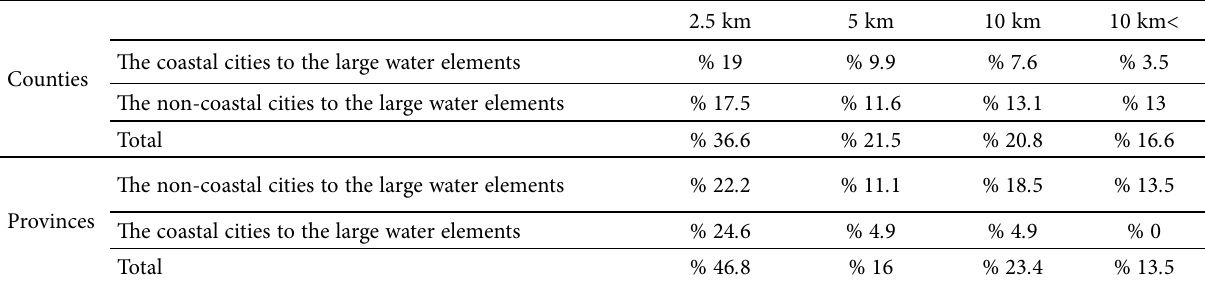
Table 4. Distribution of counties and provinces according to distances